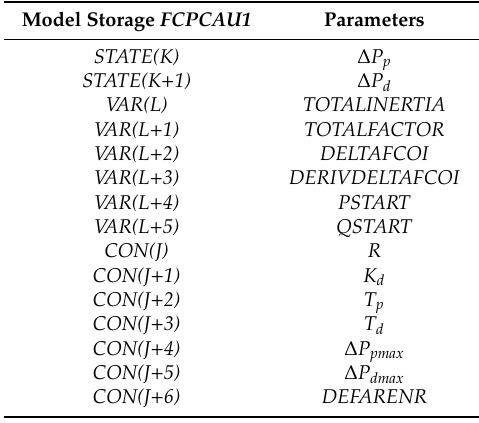
Figure 4. FCPCAU1 wind inertia controller structure.